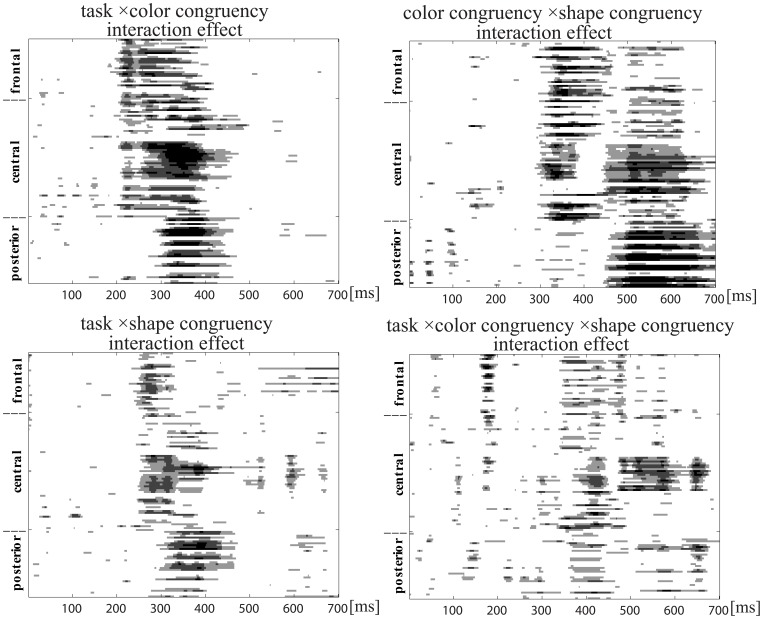
Statistical significance of 2(task: color and shape) × 2(color congruency: match and mismatch) × 2(shape congruency: match and mismatch) ANOVA task at each time point at each electrode.